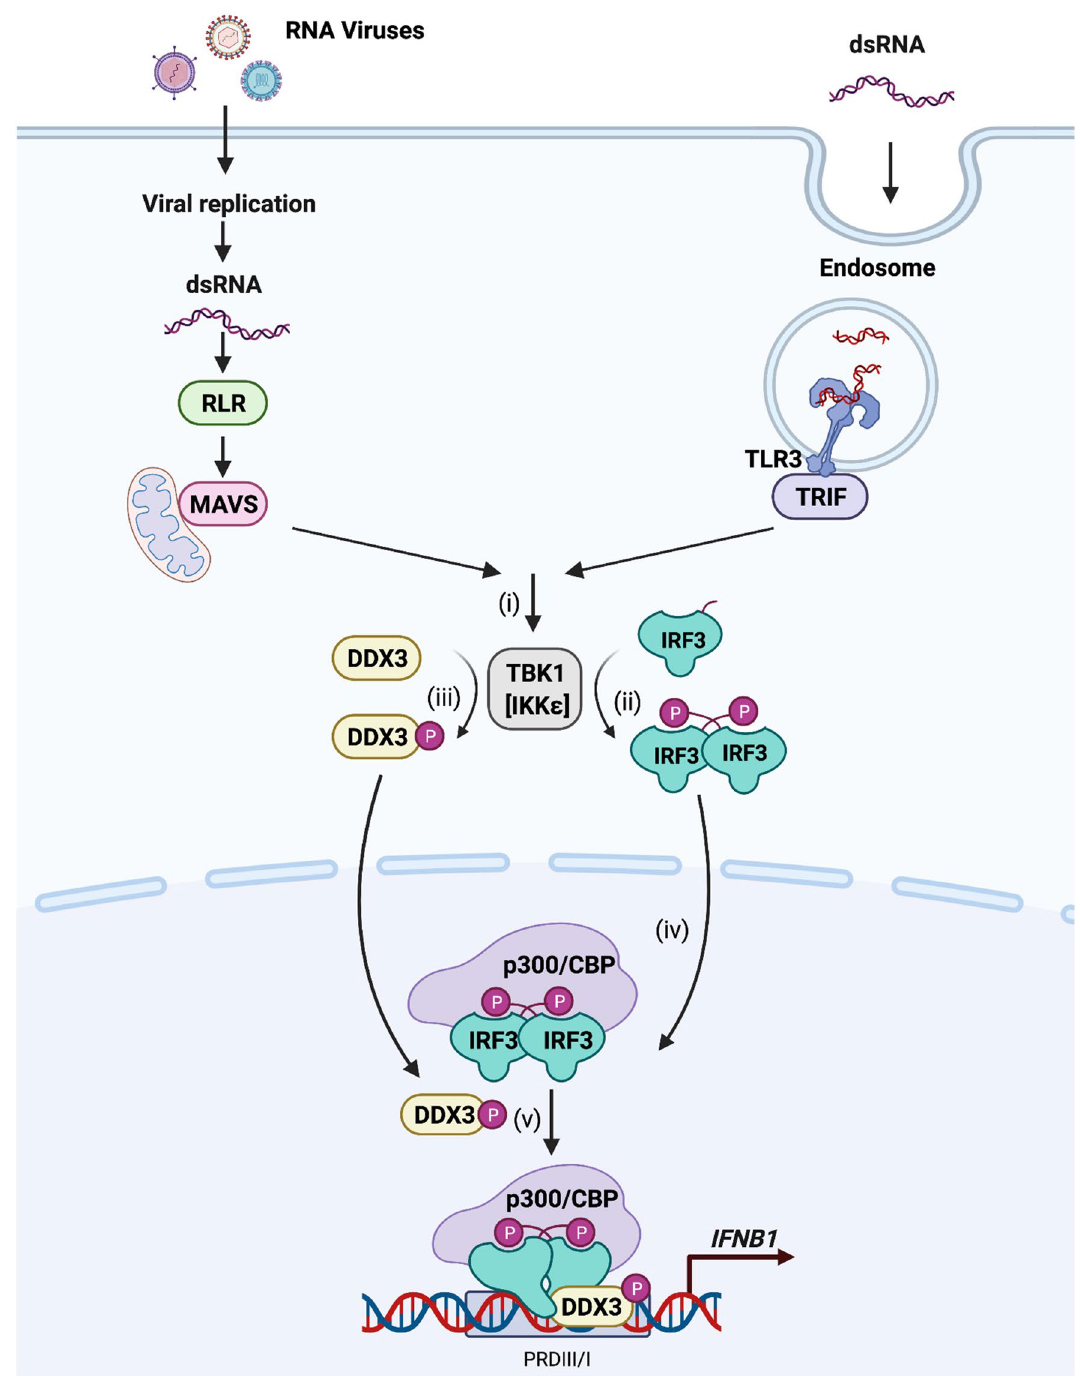
Figure 7. Proposed model for the functional role of DDX3 in RLR/TLR signaling. RLR/TLR3 senses viral dsRNA then transmits a signal to activate TBK1 (or IKK ɛ ,) (i). TBK1 interacts and phosphorylates IRF- 3, leading IRF-3 to dimerize (ii); at the same time, TBK1 phosphorylates DDX3 25,26 (iii). Dimerized IRF-3 translocates to the nucleus, forming a complex with p300/CBP (vi). Phosphorylated DDX3 is recruited to the IRF-3/p300/CBP complex to confer its full binding activity to the IFNB promoter